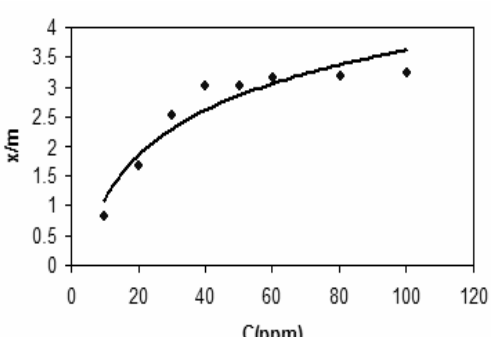
Figure 2 . Effect of initial concentration on the removal of lead ion by PANi